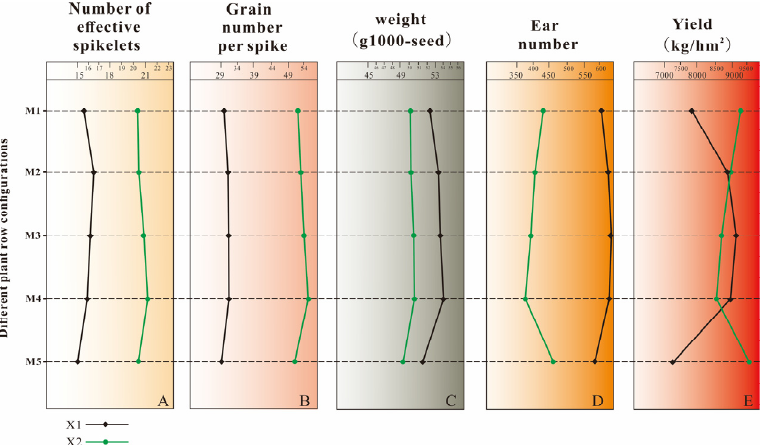
Figure 6. Yield measurement of winter wheat treated with different varieties and densities. ( A ) Number of effective spikelets, ( B ) Grain number per spike, ( C ) weight, ( D ) Ear number, ( E ) Table 1. Yield measurement data of winter wheat under different plant row configurations.